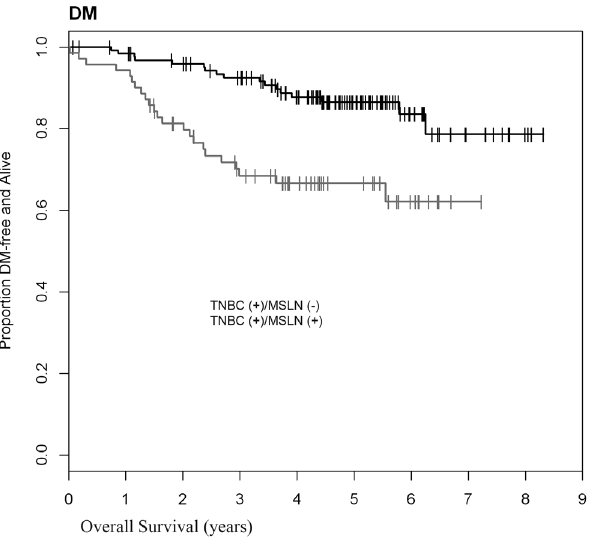
Fig. 4. MSLN expression in TNBC correlates with significantly decreased disease-free survival (p 5 0.0003, n 5 198). *Distant metastasis (DM) status unknown in 28 TNBC